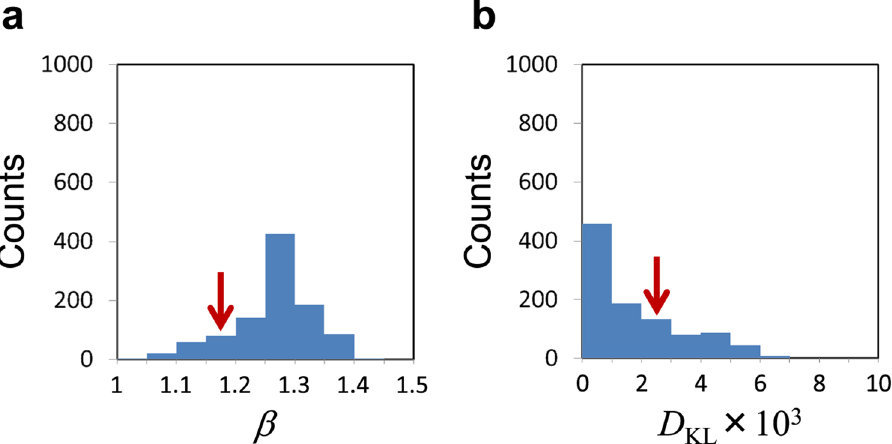
and h { } are chosen randomly i i j , KL